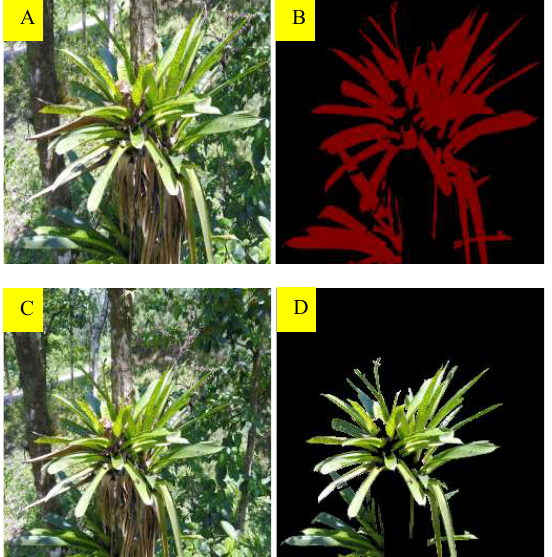
Figure 1. The input image (A) and corresponding annotation image (B) generated by the first study. The input image (C) and the annotation image (D) generated by the present study.